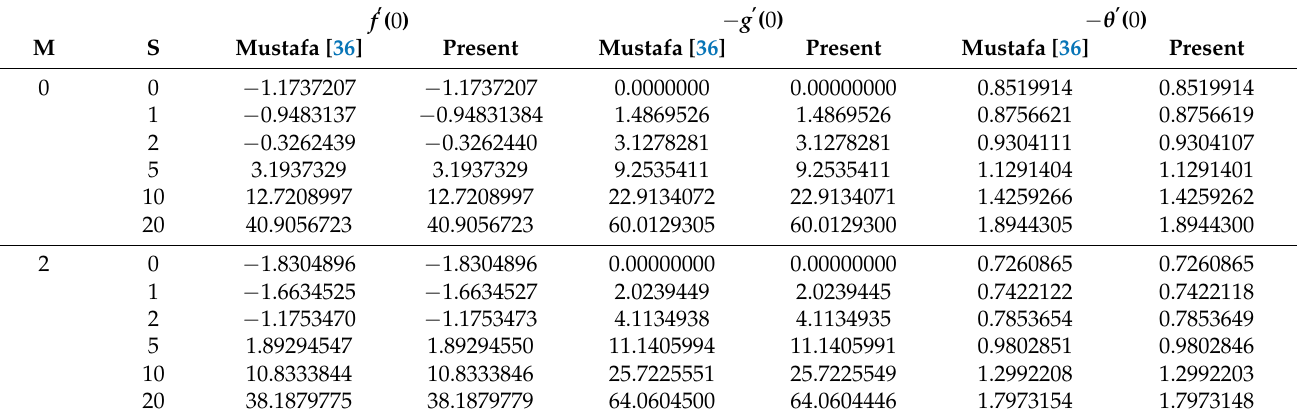
Table 2. Comparison of radial and azimuthal velocities and heat transfer rate at Ec = φ = 0 and Pr = 1.